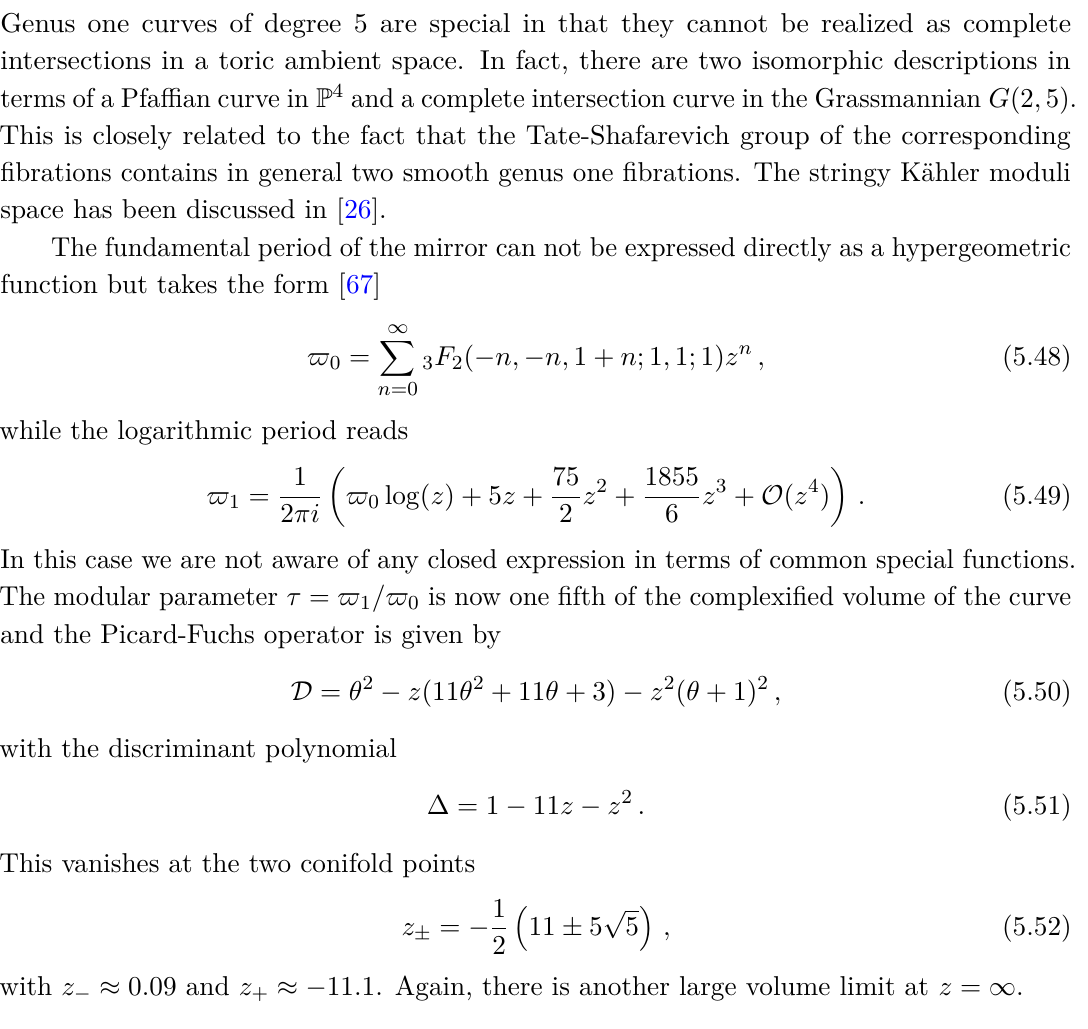
with 5 -sections, the large volume points in the Γ 1